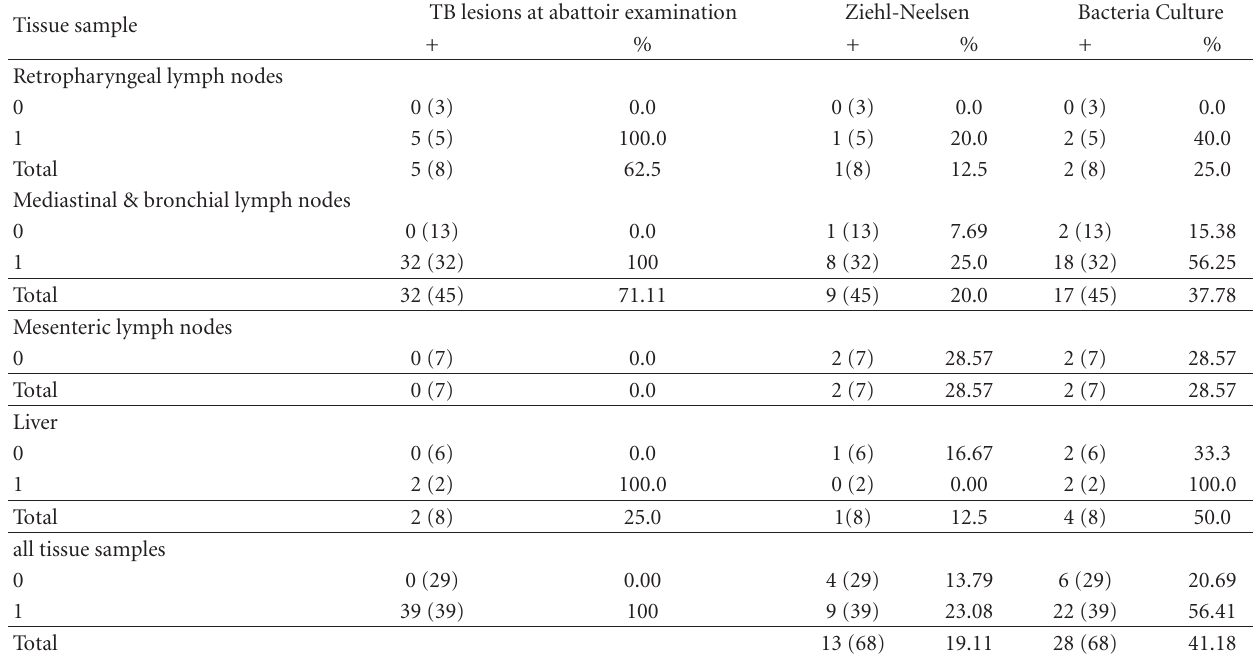
Table 1: E ff ect of diagnostic techniques and origin of tissues on the detection rate of bovine tuberculosis. Tissue